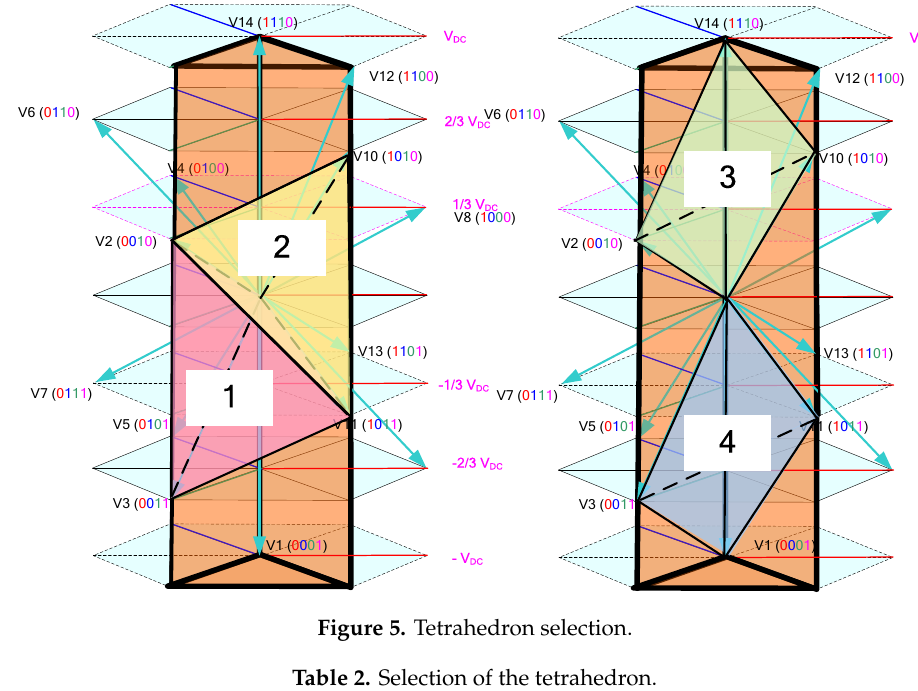
Figure 5. Tetrahedron selection. Table 2. Selection of the